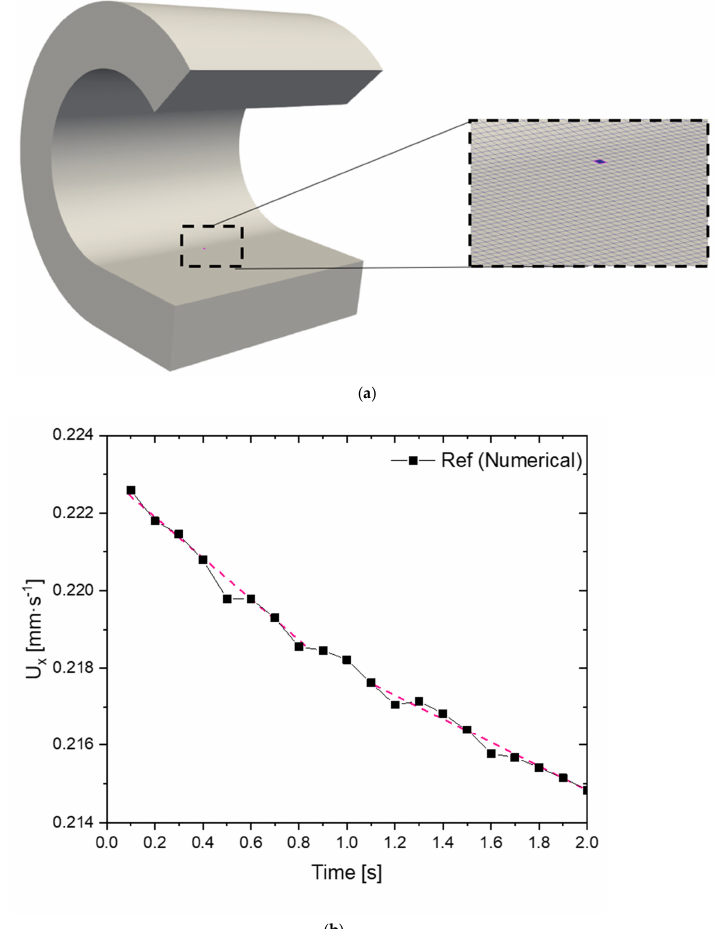
Figure 9. Detailed analysis of computational cell numerical results: ( a ) cell location and ( b ) x component of velocity evolution.